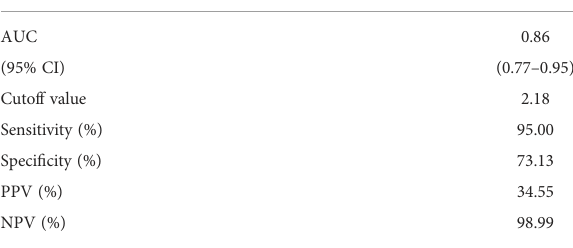
TABLE 6 The predictive performance of the risk model in predicting temporary postoperative adverse symptoms after CBT surgery